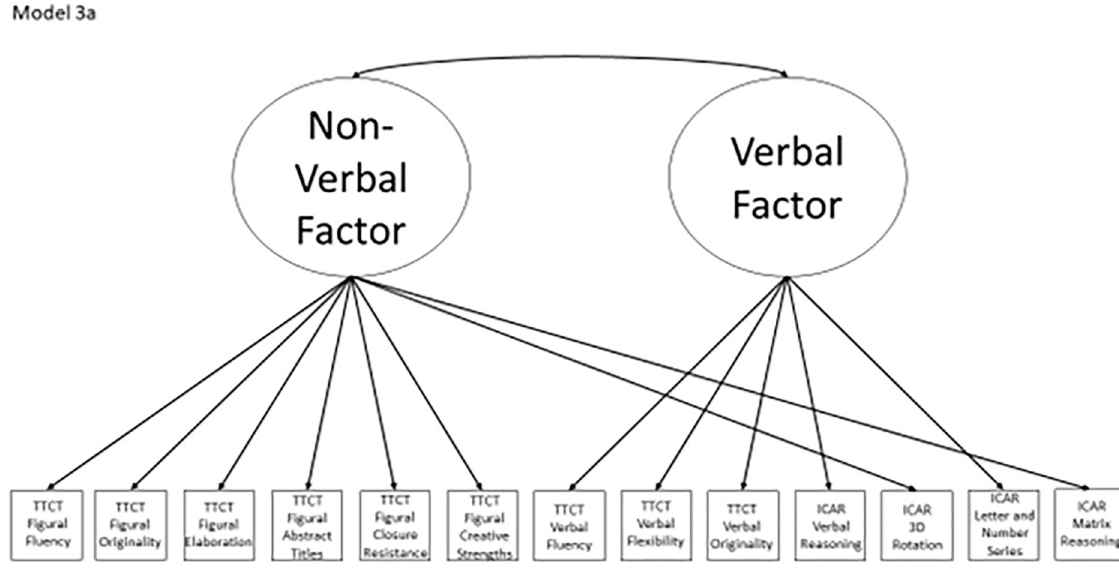
Fig 4. Confirmatory factor analysis diagram for model 3a.